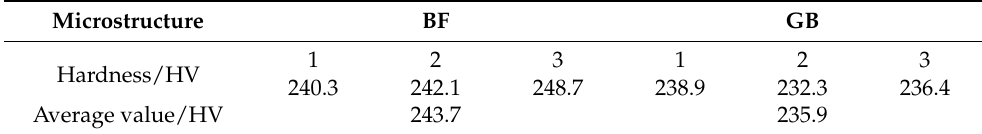
Figure 7. Surface situation of cold bending samples of the joint. ( a ) surface; ( b ) side.